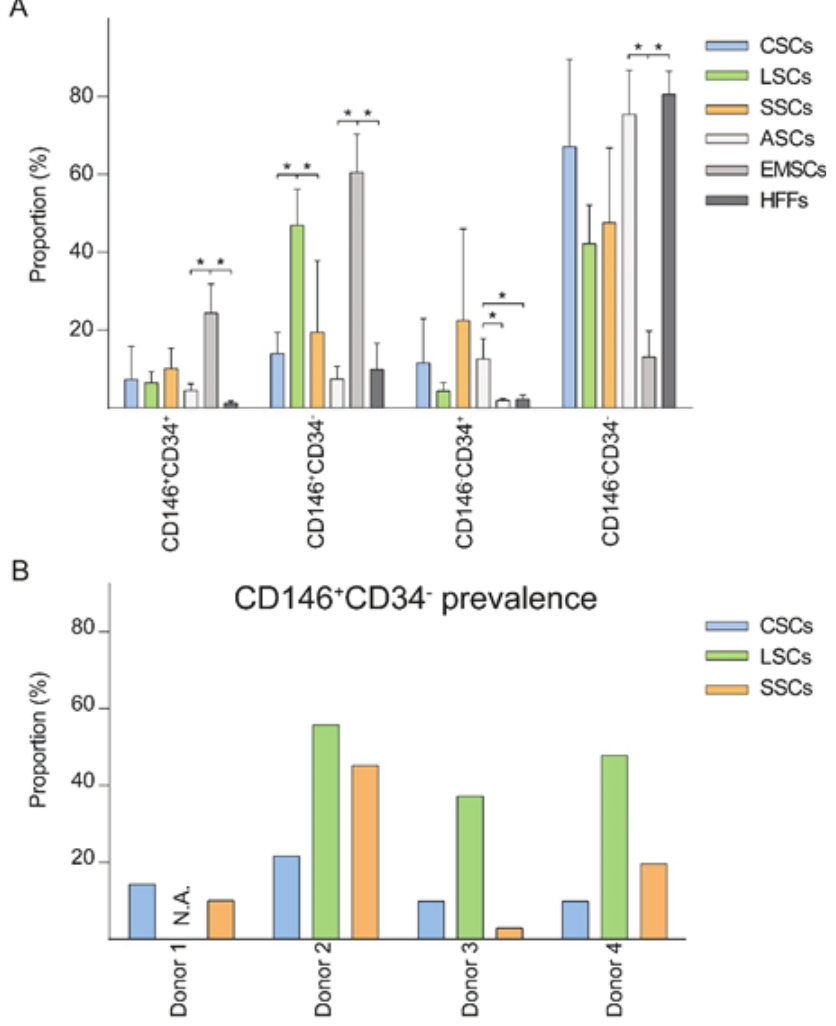
Figure 4. Co-expression of the CD146 and CD34 in human ocular surface stromal cells with reference to mesenchymal stem cells and fibroblasts. (A) Occurrence of pericytic (CD146+CD34–), adventitial (CD146–CD34+), and intermediate-like (CD146+CD34+) phenotypical variants. The data are presented as Means + SD and asterisks indicate statistical significance at p < 0.05. N = 4 for CSCs and SSCs, and n = 3 for LSCs, ASCs, EMSCs, and HFFs. (B) Inter-donor variability of the CD146+CD34– pericyte-like phenotype. CSCs, corneal stromal cells; LSCs, limbal stromal cells; SSCs, scleral stromal cells; ASCs, adipose-derived stem cells; EMSCs, endometrial mesenchymal stem cells; HFFs, human foreskin fibroblasts; N.A., not